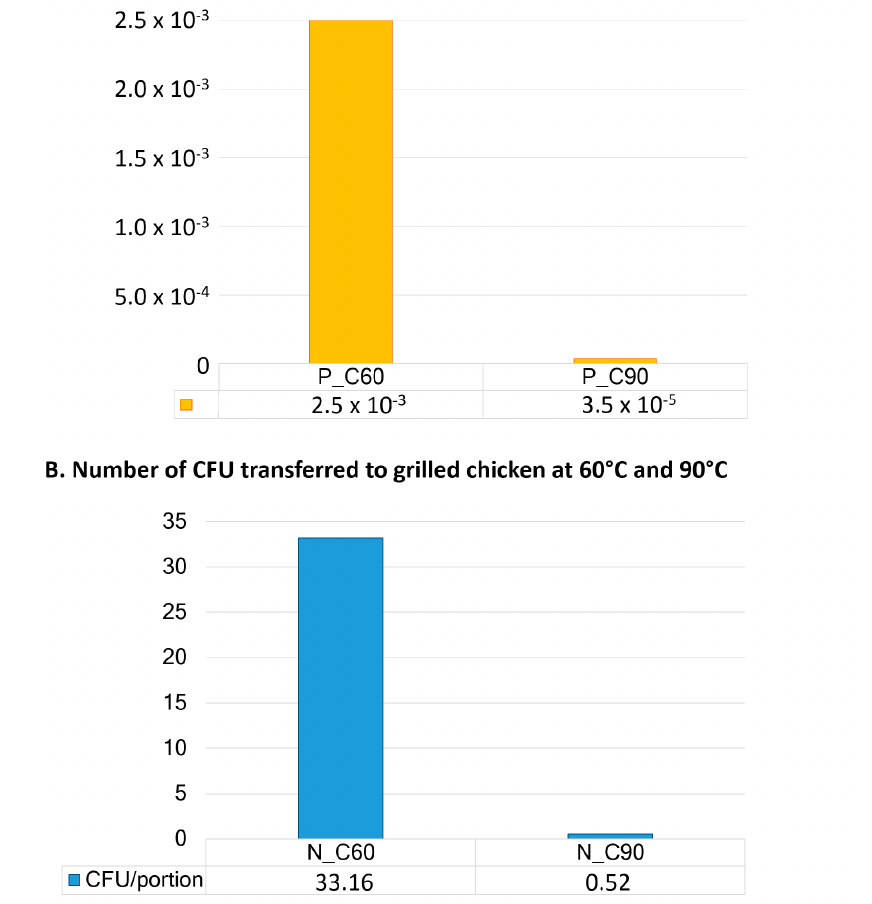
Figure 4. Influence of the temperature of the grilled chicken at time of manipulation before con- sumption (90 °C/60 °C) on the ( A ) mean probability of one CFU of ESBL-/AmpC-producing E. coli being transferred to grilled chicken and ( B ) number of ESBL-/AmpC-producing E. coli transferred (on average) to a portion of grilled chicken.